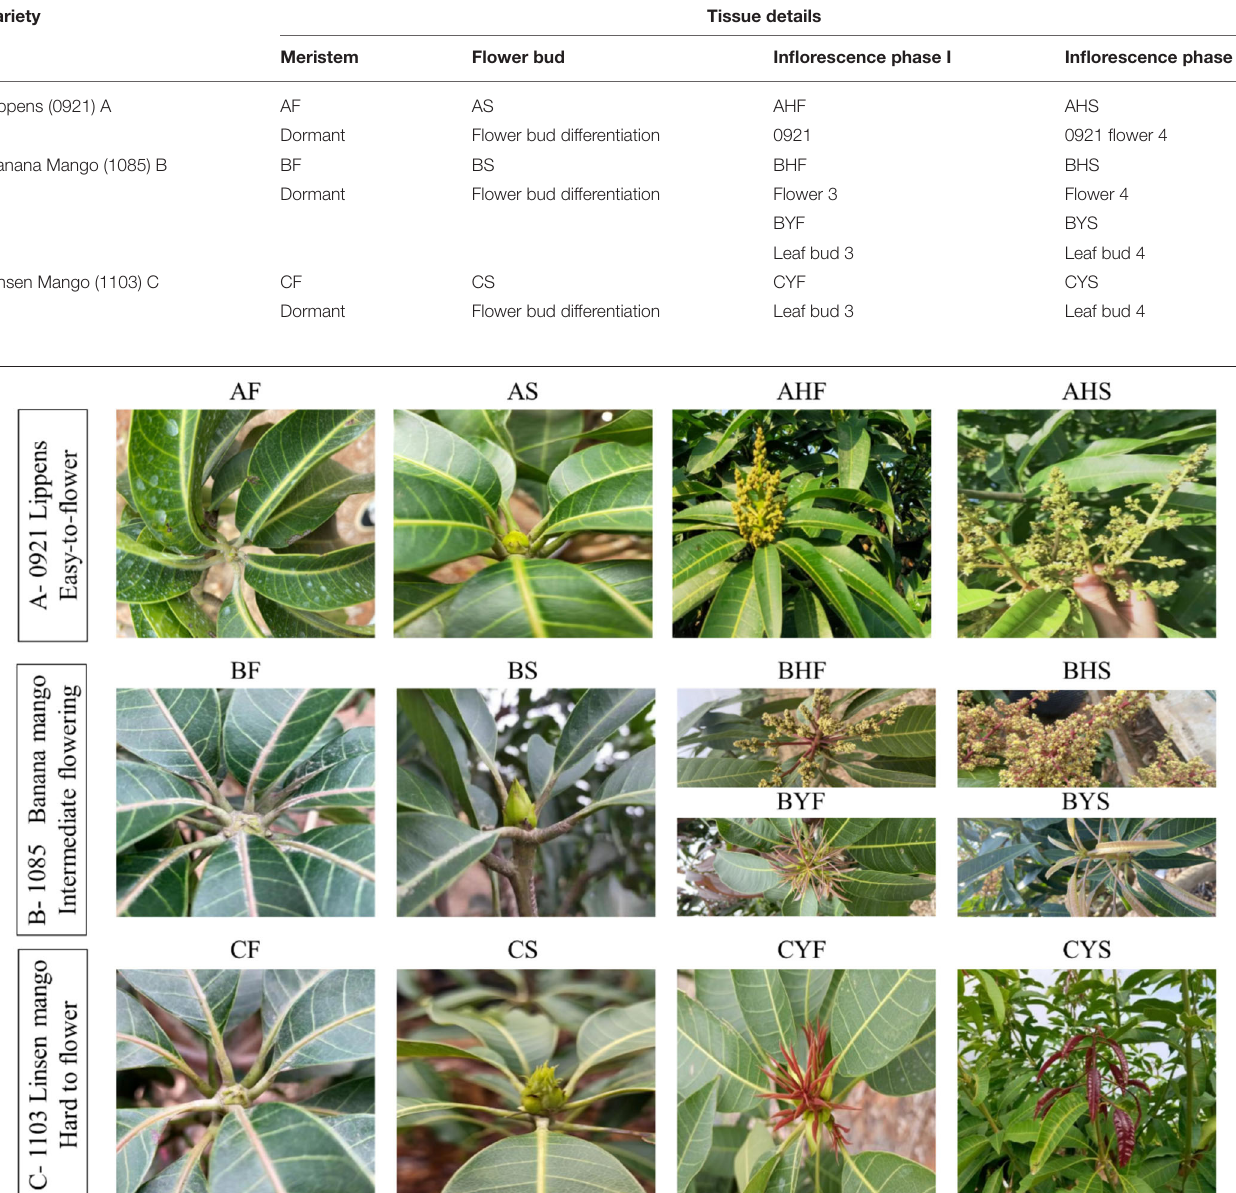
For variety B, two additional tissues were collected, i.e., leaf bud 3 and leaf bud 4, for the trees that bear no flowers. The sample naming strategy is explained in Table 1 and Figure 1